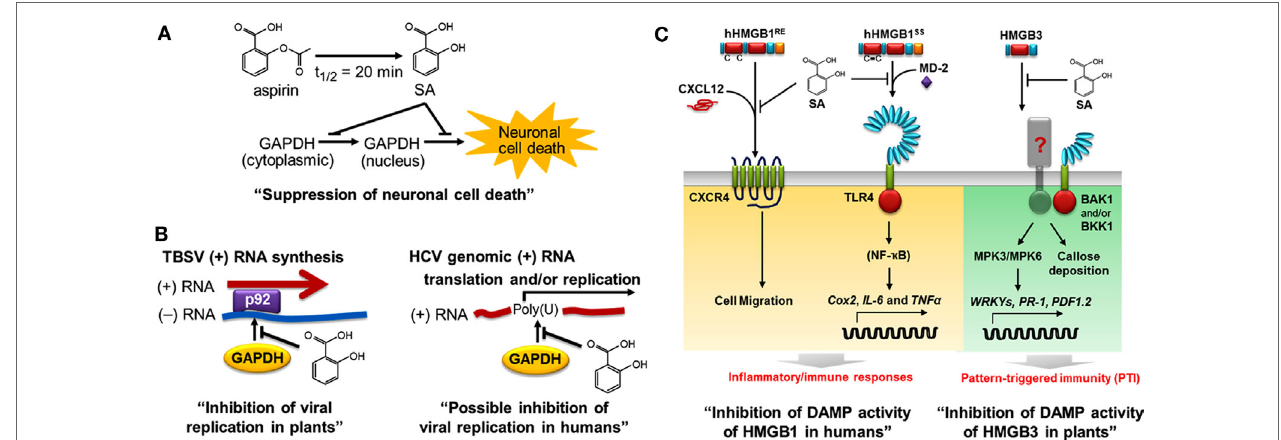
FiGURe 3 | Salicylic acid (SA) affects both plant and human health, in part through common targets such as GAPDH and HMGB proteins . In plants, SA is a key hormone that modulates immune responses; in humans, it is the major metabolite of aspirin. (A) SA binds to human GAPDH and suppresses its translocation from cytoplasm to nucleus and the resulting cell death (14). (B) SA binds to GAPDH and suppresses its participation in viral replication. In plants, GAPDH binding to the minus ( − ) RNA strand of tomato bush stunt virus (TBSV) promotes plus ( + ) RNA strand synthesis by the viral RNA-dependent RNA polymerase p92 (82). SA inhibits the interaction between plant GAPDH and the ( − ) RNA strand of TBSV, thereby reducing viral replication (left panel) (43). In humans, Petrik et al. (83) reported that human GAPDH binds to the poly (U) tract of genomic hepatitis C virus (HCV) RNA, while SA and aspirin were subsequently shown to suppress HCV replication (84, 85). We found that SA inhibits human GAPDH binding to poly (U), suggesting that SA has a similar mechanism of action for inhibition of HCV and TBSV (right panel, Tian and Klessig, unpublished results). (C) SA inhibits the DAMP activities of HMGBs in humans (left panel) (15) and in plants (right panel) (44). Extracellular human HMGB1 functions as a damage-associated molecular pattern (DAMP or alarmin). SA binds to HMGB1, thereby inhibiting the pro-inflammatory activities of reduced and disulfide-bonded HMGB1 (hHMGB1 RE and hHMGB1 SS , respectively). C–X–C chemokine receptor 4 (CXCR4) recognizes the heterocomplex of hHMGB1 RE and C–X–C motif-containing chemokine 12 (CXCL12) to induce cell migration, while the toll-like receptor 4 (TLR4) binds the heterocomplex of hHMGB1 SS and myeloid differentiation factor 2 (MD-2) (86) to activate expression of Cox2 and pro-inflammatory cytokine genes ( IL-6 and TNF α ). SA blocks these pro-inflammatory pathways (15). In plants, HMGB3 functions as a DAMP. Extracellular HMGB3 activates pattern-triggered immunity responses, including MAPK activation (MPK3 and MPK6), defense-related gene expression (WRKYs, PR-1 , and PDF1.2 ), and callose deposition. The regulatory receptor-like kinases BAK1 and/or BKK1 are required for HMGB3 signaling through a yet to be discovered receptor. This figure is modified from Klessig